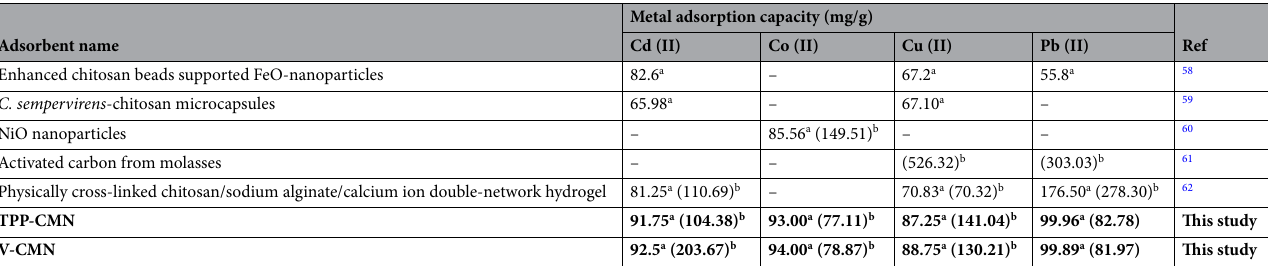
Table 5. Comparison of adsorption capacities of various adsorbents for Cd (II), Co (II), Cu (II) and Pb (II) ions from published literature. a From experimental data. b From Langmuir isotherm model. The significant values are in